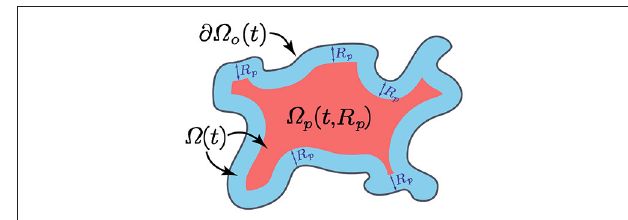
FIGURE 2 | Schematic of the re-polarisation domain (cid:127) p ( t , R p ) that is highlighted with red.